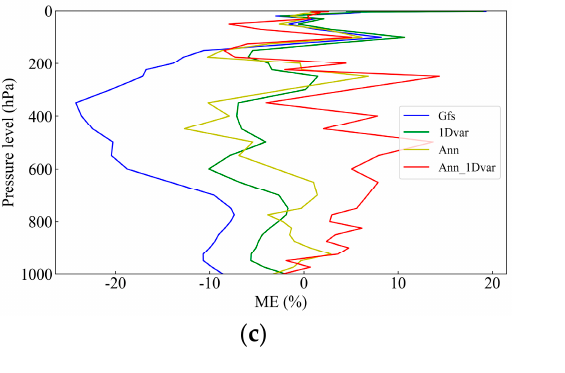
Figure 6. A comparison of the retrieval profile and initial profile, where the true value is taken from ERA5 data: ( a ) 1–1000 hPa RMSE (%) of two initial profiles and two retrieval profiles, ( b ) 1–200 hPa RMSE (%), ( c ) 1–1000 hPa ME (%), ( d ) 1–200 hPa ME (%). The blue line, GFS, is the ozone profile of GFS forecast data, and the green line, 1Dvar, is the traditional 1D − VAR physical retrieval algorithm retrieval ozone profile result obtained with GFS data as the initial profile. The yellow line, Ann, is the profile obtained by the neural network model and the initial profile synthesized by GFS data, while the red line, Ann_1Dvar, is the retrieval result obtained by adding the neural network method to optimize the initial profile combined with the traditional 1D − VAR physical retrieval algorithm.